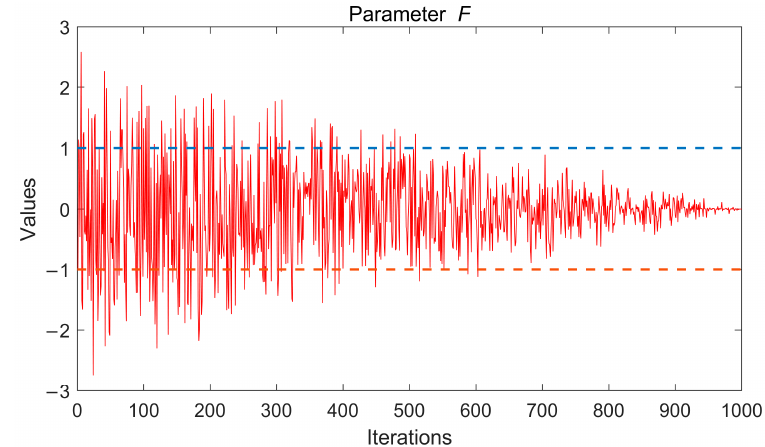
Figure 3. Dynamic behavior of F during 1000